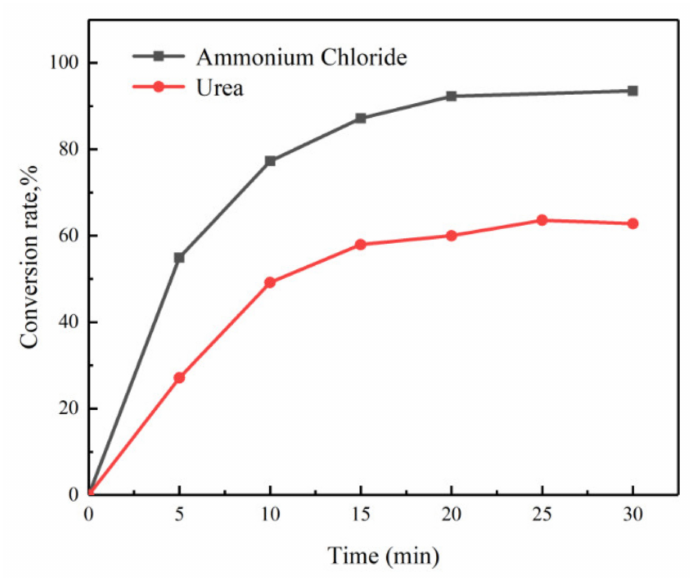
Figure 7. Effect of reaction time on the digestion of ammonium chloride and urea.